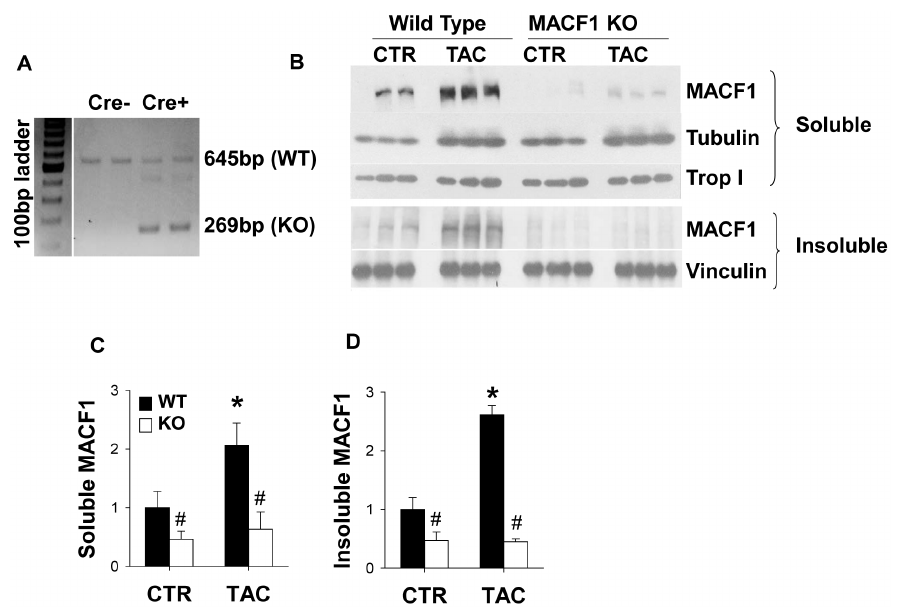
Figure 1. MACF1 expression is increased in response to pressure overload. RT-PCR was performed to amplify between exons 10 and 14 of MACF1. A 269 b.p. band corresponding to splicing between exon 10 and 14 (indicating loss of exons 11–13) is observed only in MACF1 KO mice, whereas WT mice express only the predicted size of 645 b.p. (Figure 1A) Western blot analysis of triton soluble (Figure 1B and 1C) and insoluble fractions (Figure 1B and 1D) of ventricular lysates of WT and MACF1 KO mice under control or after 3 weeks of TAC conditions (total of 7 weeks after tamoxifen treatment) demonstrates MACF1 expression increases in response to TAC, and is effectively silenced in MACF1 KO hearts (graphs represent averages of 3 WT or KO control mice, and 9 WT and KO TAC mice). Troponin I and vinculin were used as loading controls. (* indicates p , .05 as compared to control conditions, # indicates p , .05 as compared to WT under same conditions).